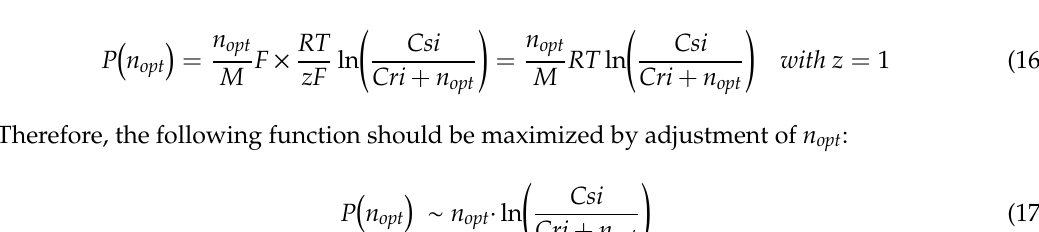
Figure 6. A RED stack with counterflow operation. Red numbers indicate salt concentrations in the river water compartment, blue in the seawater compartment. Transport parameter is given in green.